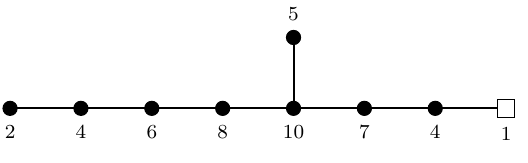
for the singularity x 2 X